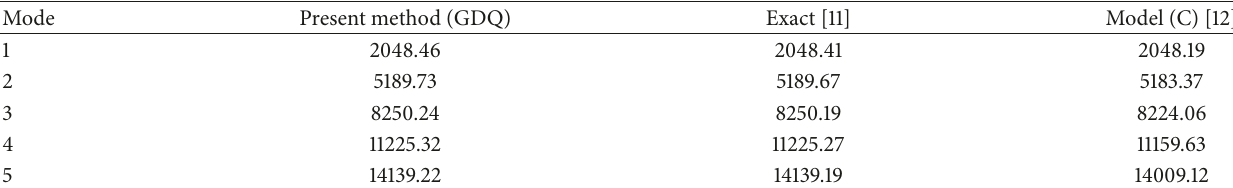
Table 2: The five low natural frequencies for a simply supported sandwich beam